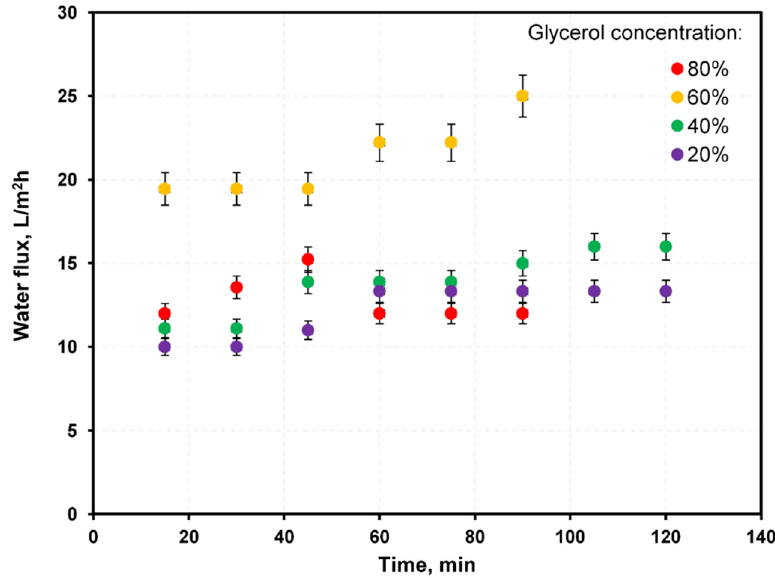
Figure 5. The measured water flux through FO Aquaporin membrane under different glycerol concentrations in a water–glycerol system.